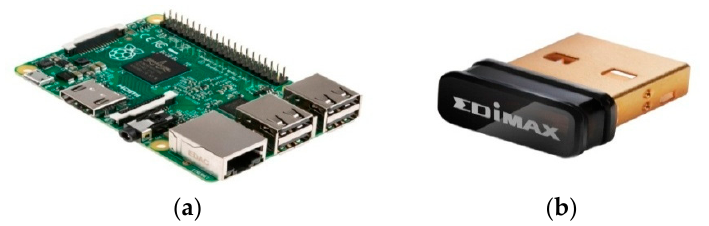
Figure 2. ( a ) Raspberry Pi model 2B; ( b ) Edimax Wi-Fi dongle.